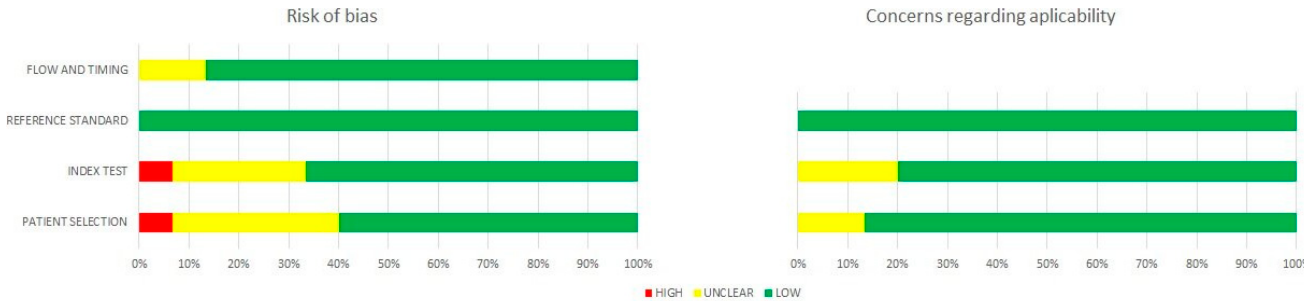
Figure 3. Summary of the quality evaluation of the included studies by means of QUADAS-2 tool.